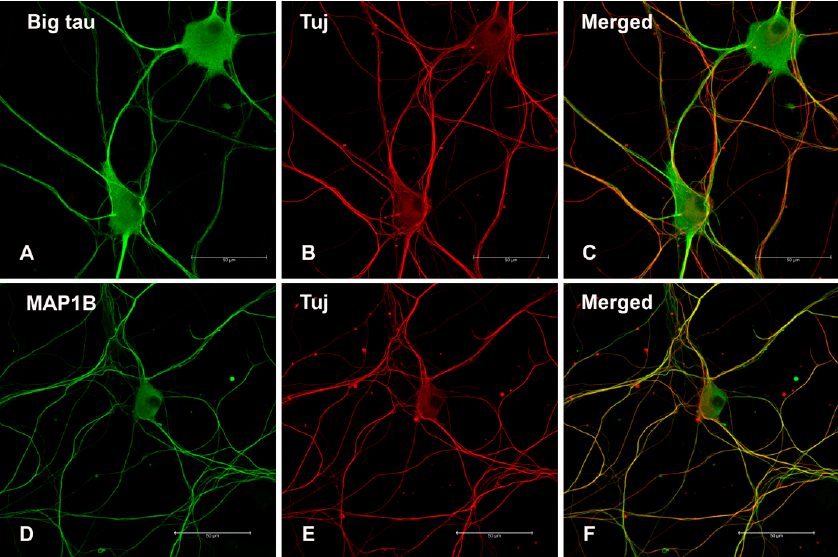
Figure 6. Cultured SCG (P3) stained with Big tau and Tuj. SCGs dissociated from P3 and cultured for 4 days show Big tau expression in both SCG cell body and neurites ( A ), which co ‐ localized with Tuj ( B , C ). The SCG cultures showed similar staining with MAP1B ( D ) which also co ‐ localized with Tuj ( E , F ). Scale bar = 50 μ m.